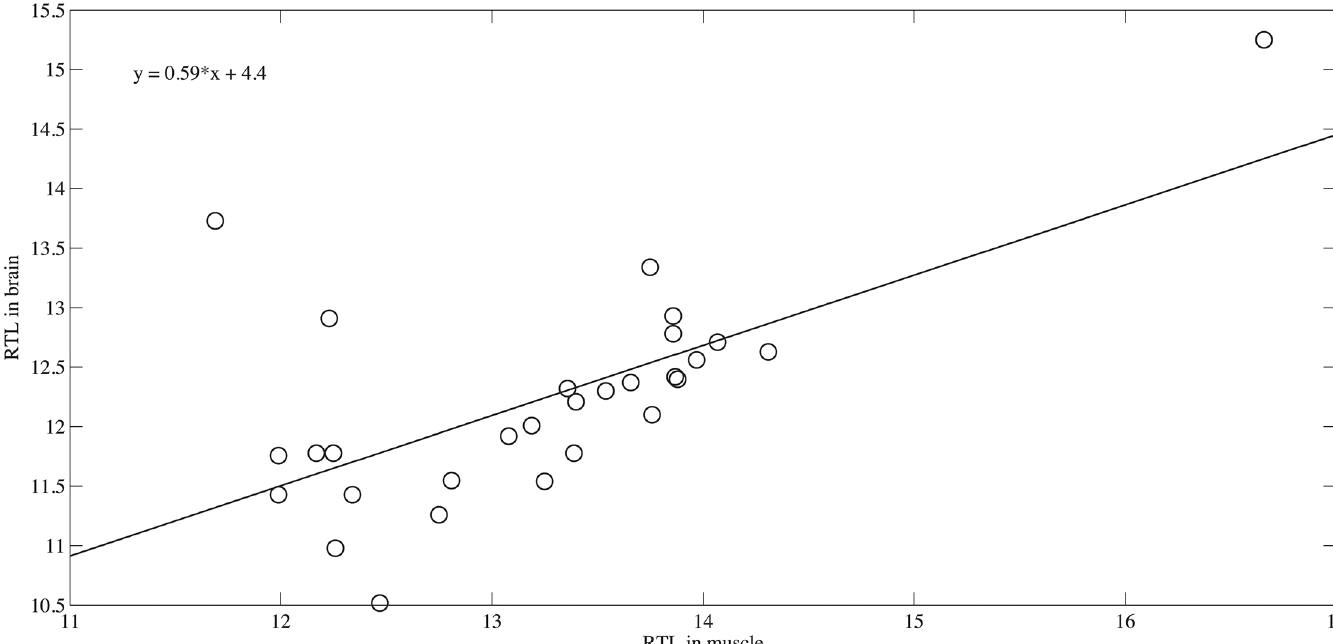
Fig 2. Correlation in RTL between brain and muscle tissue samples. Although differences between tissues were tested using a paired t-test, a linear regression is shown here for visualization.